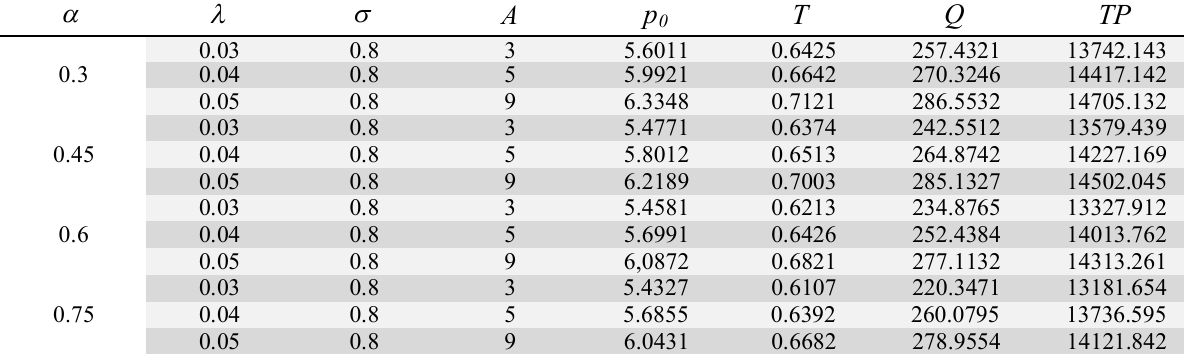
Computational results for different values of  and